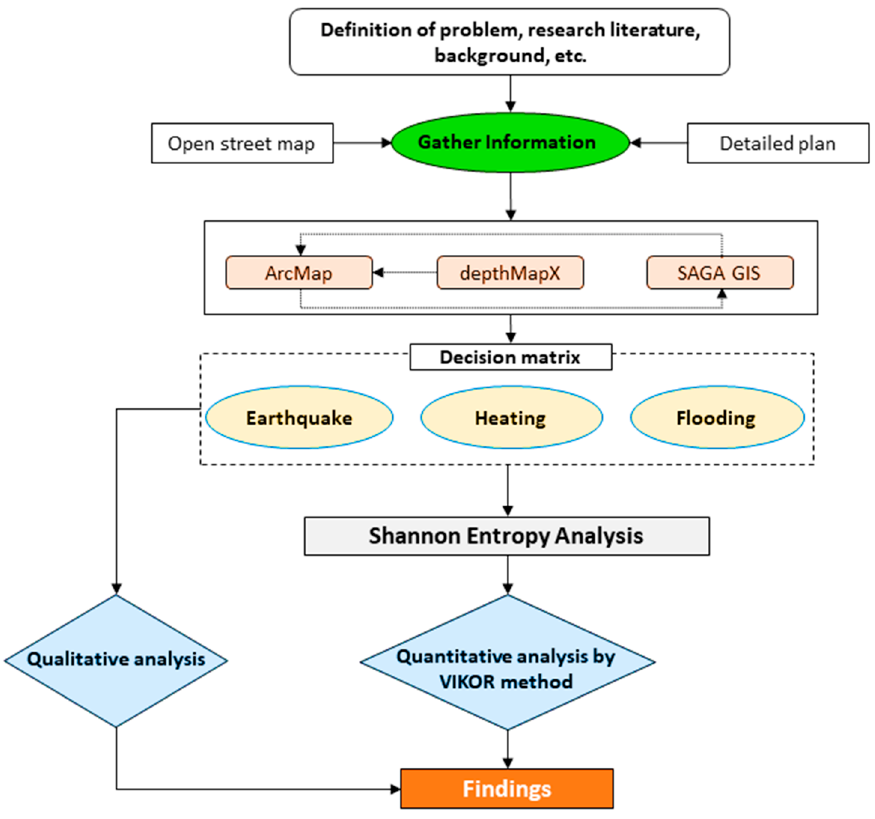
Figure 3. Flowchart of the